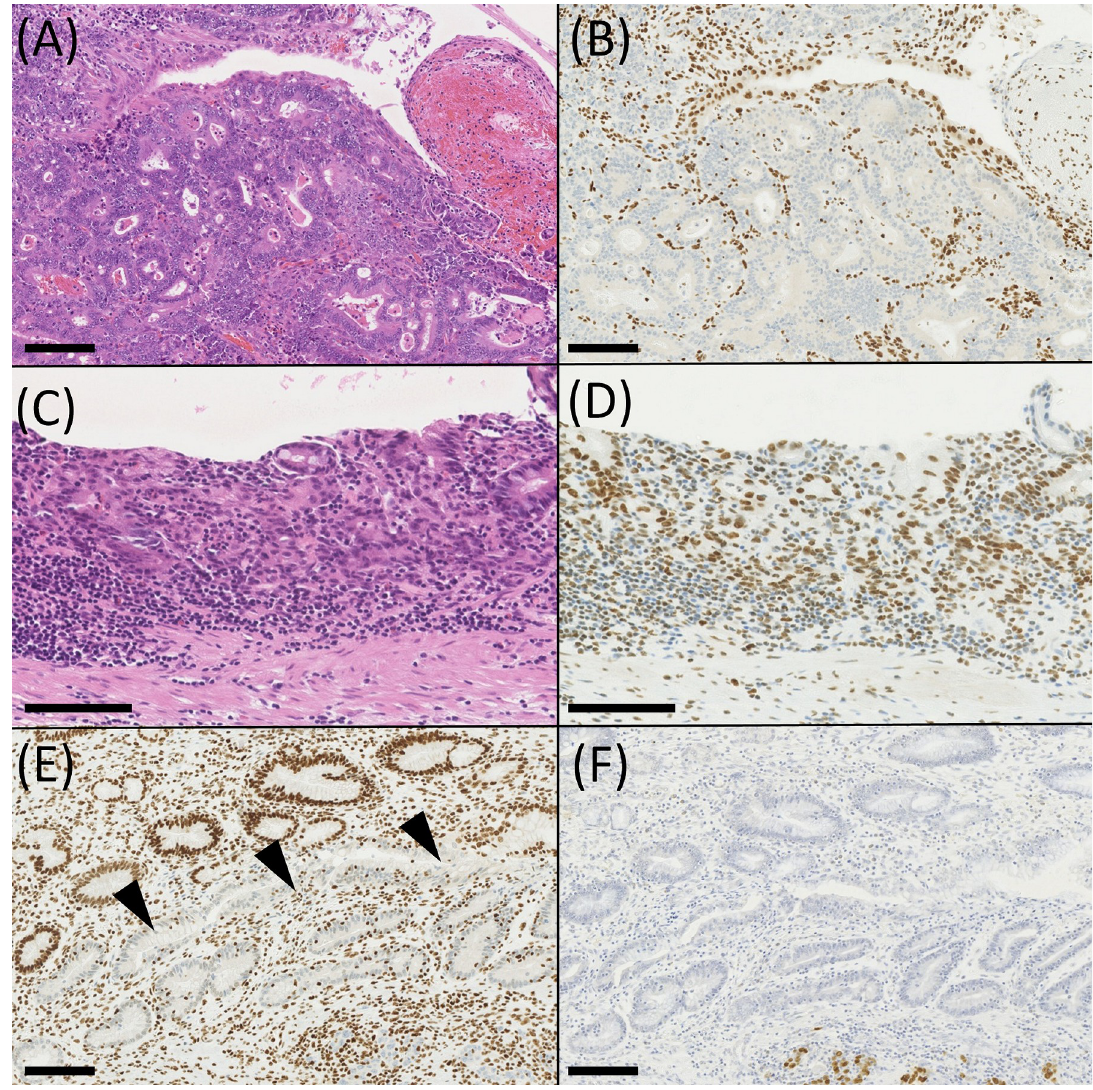
Fig 2. Histology of intramucosal carcinoma of EBVaGC. (A, B) Histology of EBVaGC with lost ARID1A, showing well-formed distinct glands with preserved lumen. (C, D) Histology of EBVaGC with preserved ARID1A. The lumen of glands was indistinct, and abortive glands and a cord-like pattern was observed. (E, F) A case of EBVaGC with lost ARID1A. EBER-negative non-neoplastic mucosa adjacent to the tumor (arrowhead) showed lost ARID1A. A and C, hematoxylin–eosin staining; B, D, and E, immunohistochemistry of ARID1A; F, EBER in situ hybridization. Scale bar, 100 μ m. instability subtype of gastric cancer (nearly 50% of total gastric cancer) [2, 20]. During the search for p53-positive cells in non-neoplastic mucosa tissues of the stomach, Ochiai et al. identified 19 foci in 756 tissue sections (2.5%) [21]. Since EBVaGC comprises 3.5–10% of gas- tric cancer with a half showing loss of ARID1A, the relative incidence of p53-positivity and EBV infection in non-neoplastic mucosa (25:2) appeared to correspond with that in gastric cancer, suggesting that both are precursors of each subtype of gastric cancer. It is worth noting that EBER-positive epithelial cells were relatively frequently identified in the proximity of gas- tric cancer with or without EBV infection, suggesting that field cancerization plays a role in the carcinogenesis of EBVaGC.